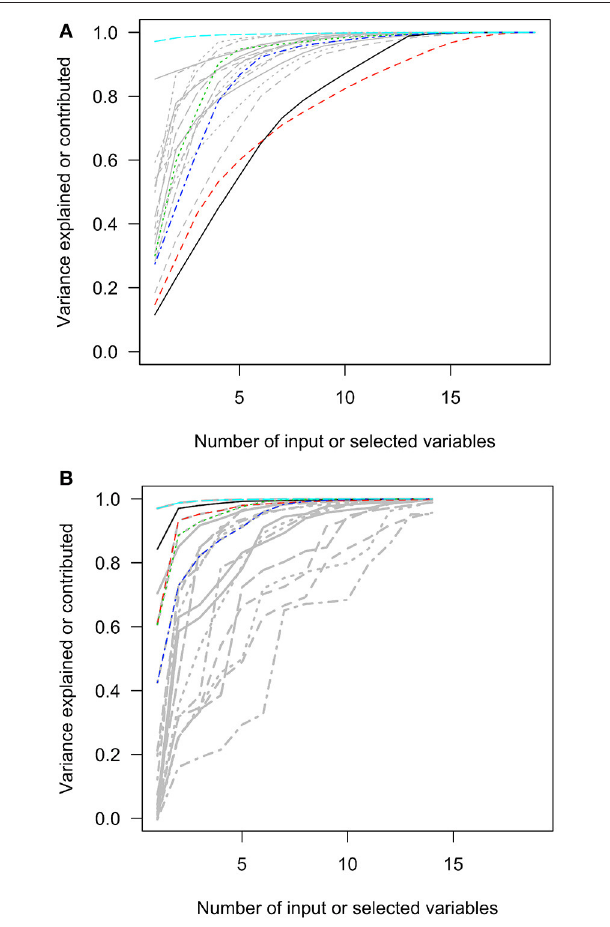
FIGURE 2 | The squared loadings in each PC and the R squared of PC approximation in the Hitters data set. (A) The squared loadings of all variables in PCs. (B) The adjusted R squared of the variables that were used to approximate PCs. PC, principal component; black, first PC; red, second PC; green, third PC; blue, fourth PC; light blue, fifth PC.